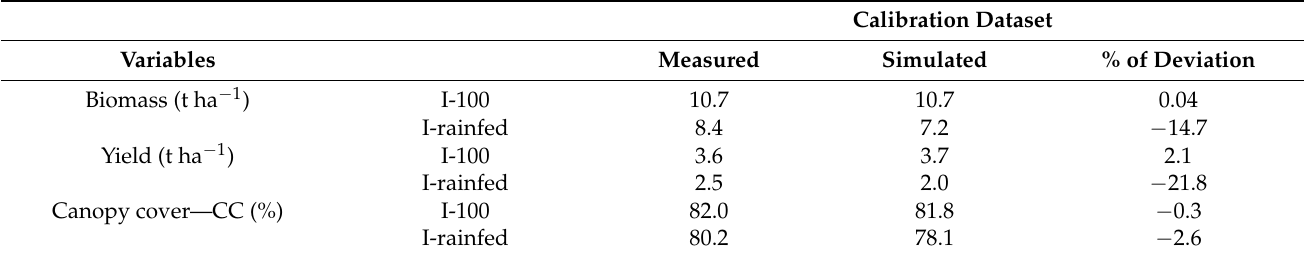
Table 4. Simulation results for the calibration data set and deviation from measured values.